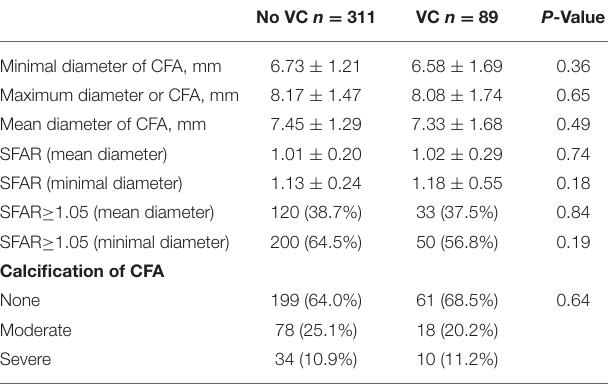
TABLE 1 | Baseline clinical characteristics. TABLE 2 | Characteristics of access site common femoral artery.